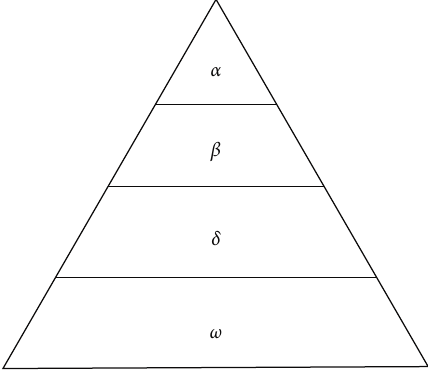
Figure 1: Classification of